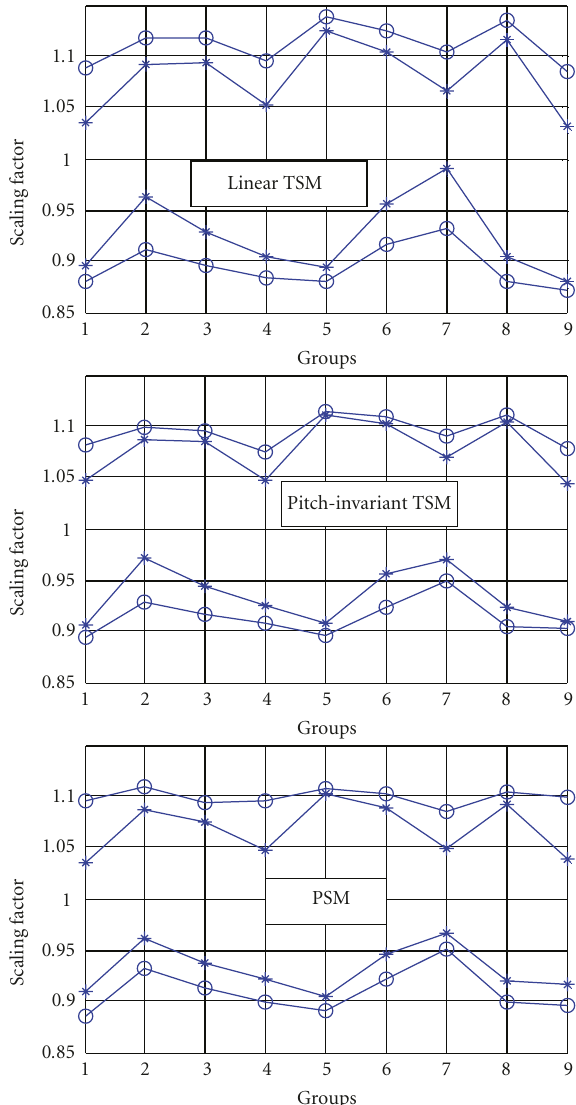
Figure 14: Average upper and lower bounds. o: Watermark length = 20, ∗ : Watermark length =